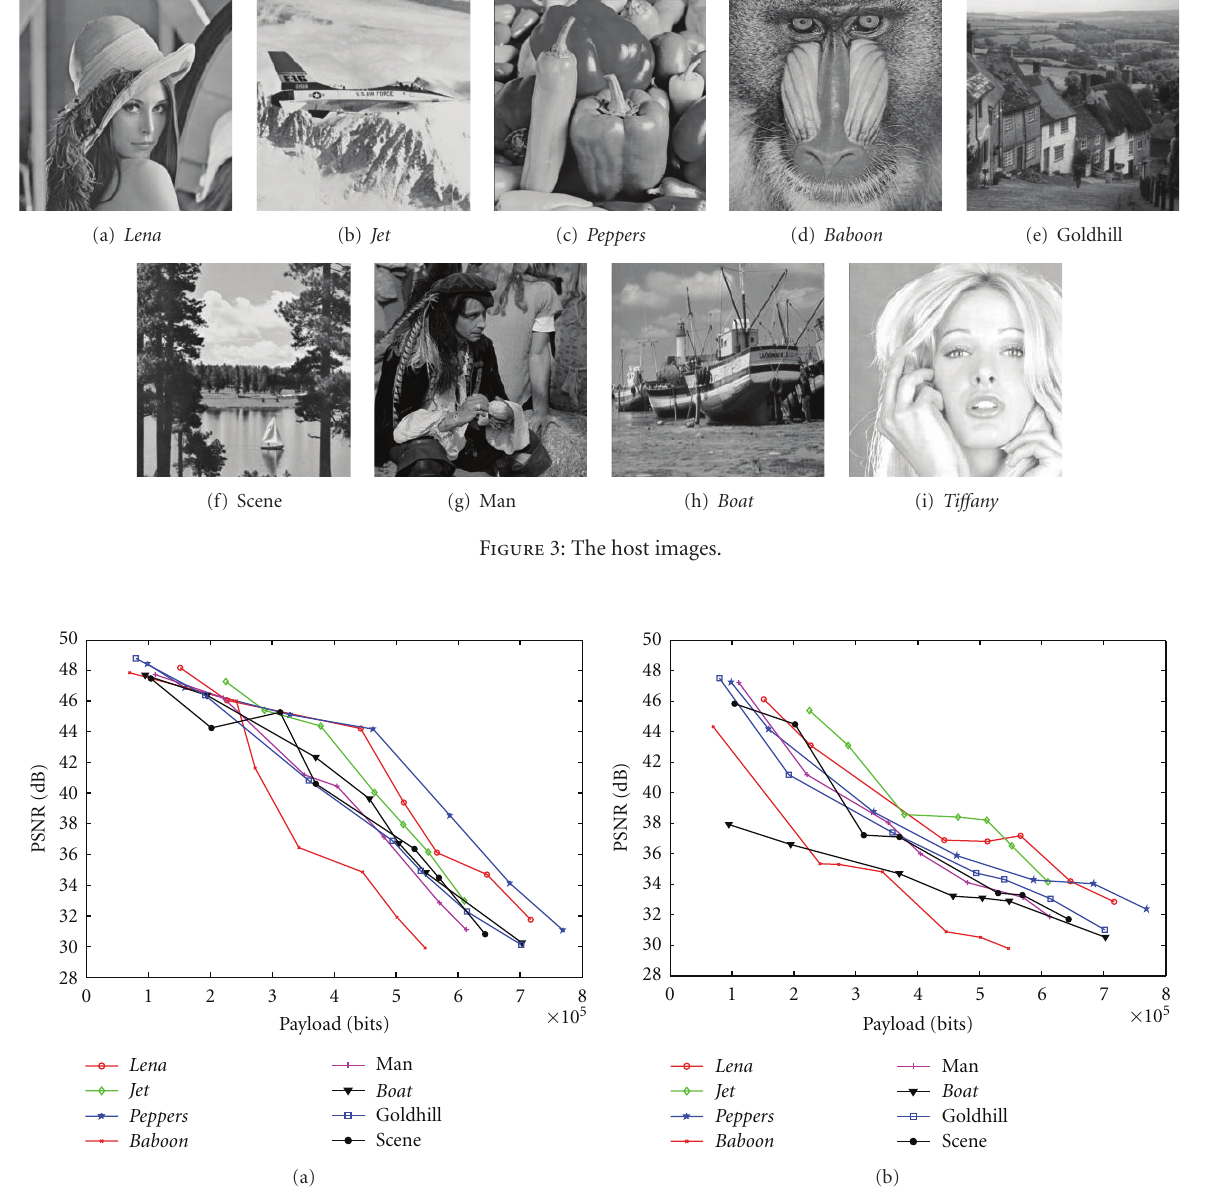
Figure 4: The relationship between PSNR and payload for the proposed method on test images. (a) Stego-image 1 and (b) stego-image 2.